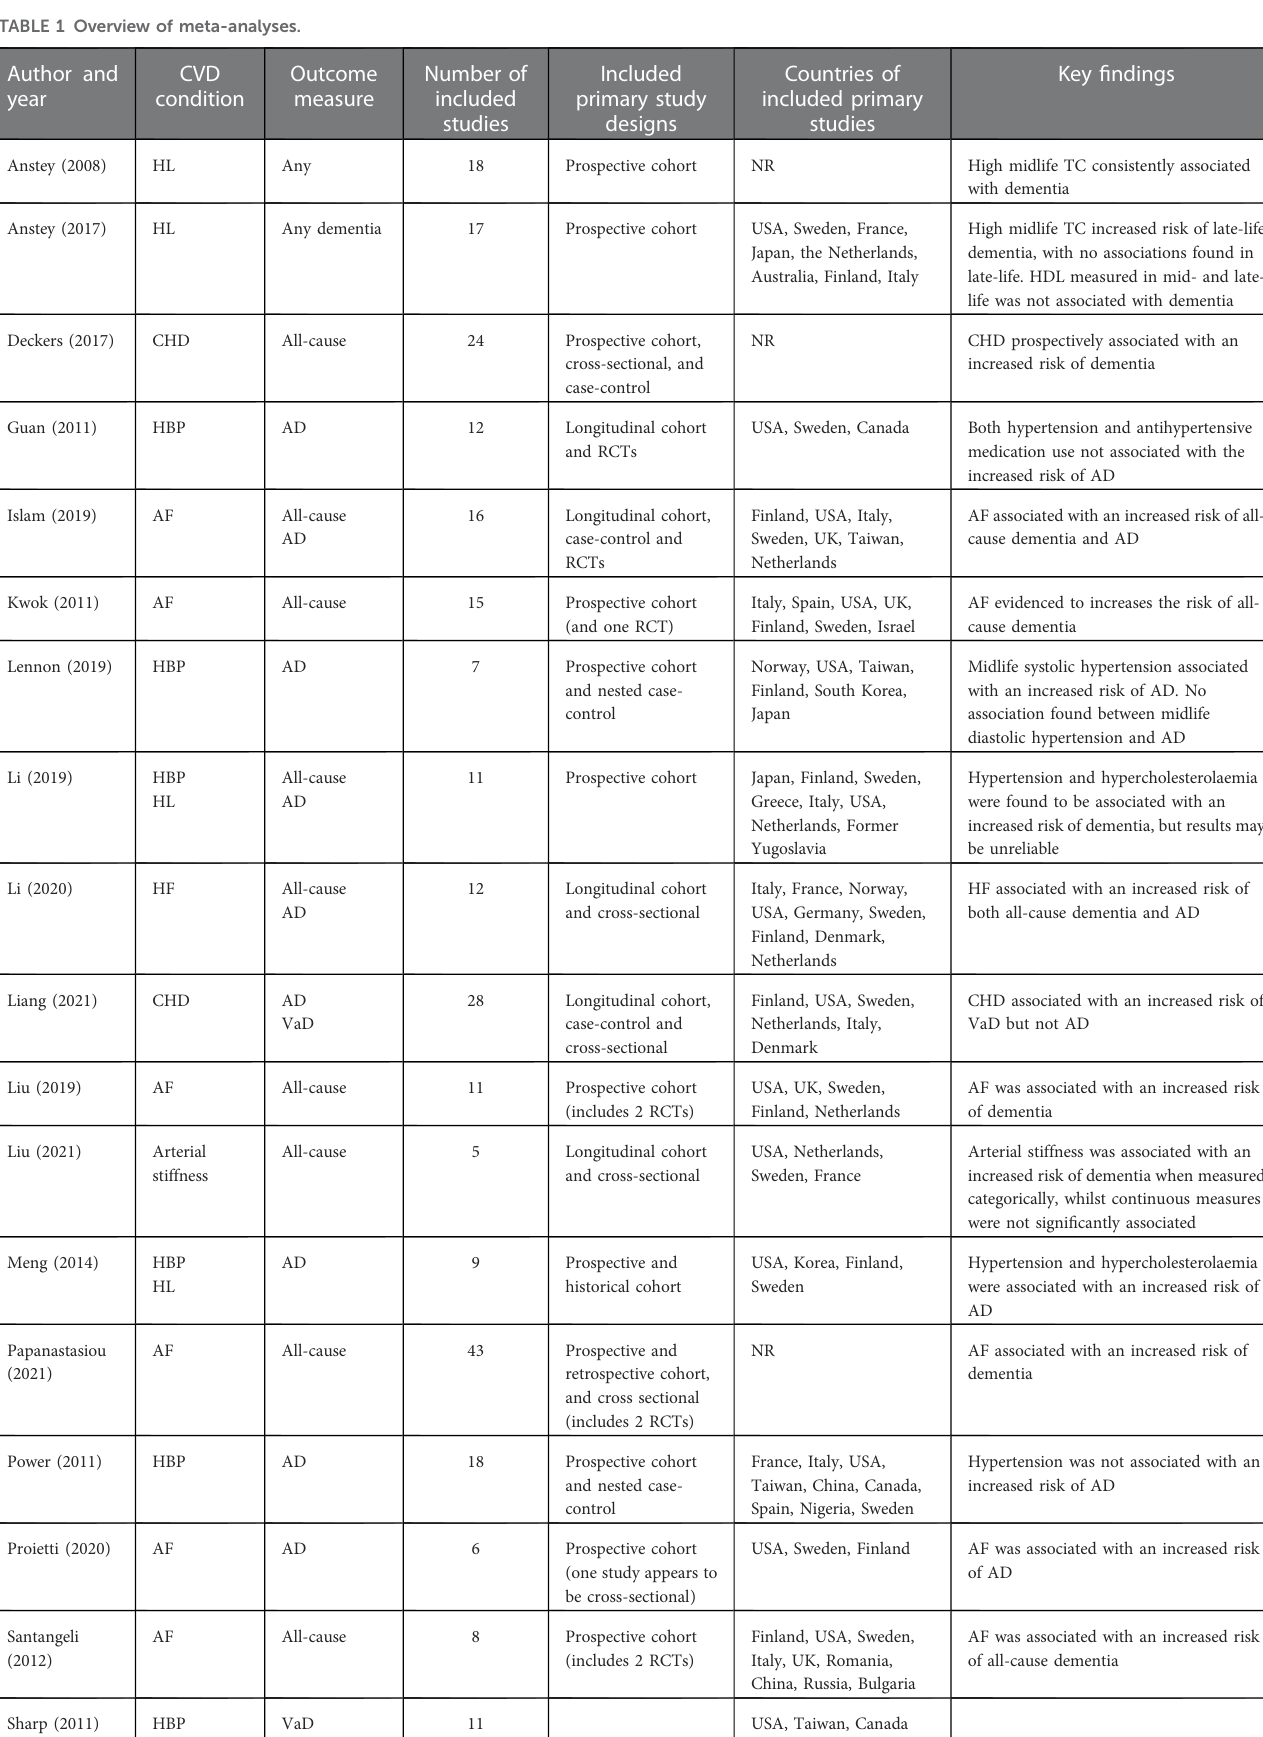
TABLE 1 Overview of